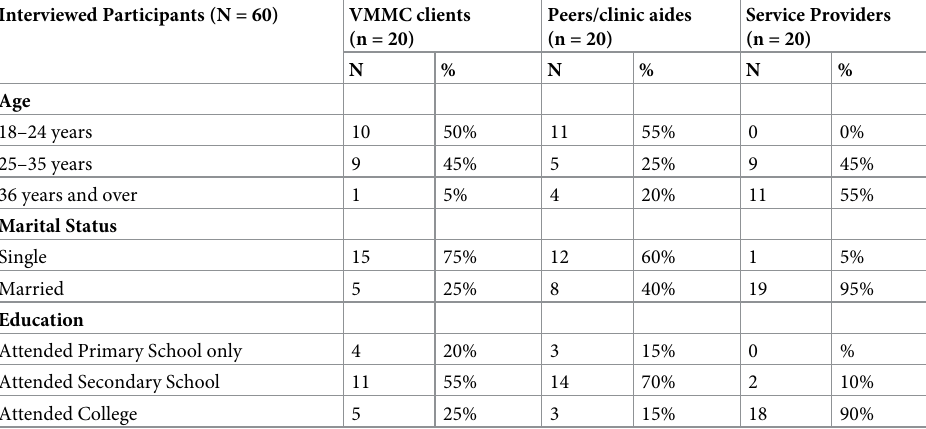
Table 3. Baseline characteristics of in-depth Interview